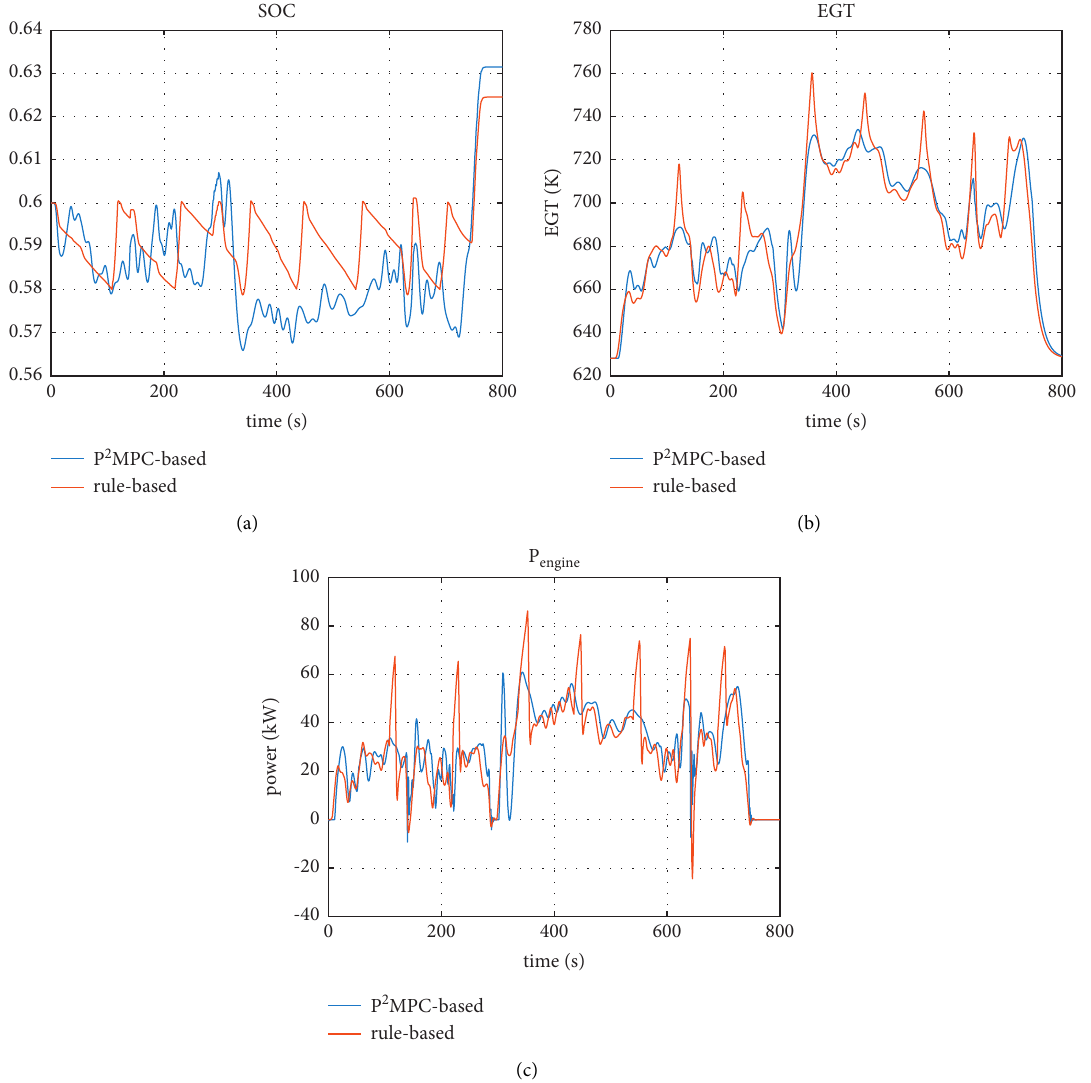
Figure 22: Simulation results comparison based on HWFET. (a) SOC of power battery. (b) EGTof turboshaft engine. (c) Output power of turboshaft